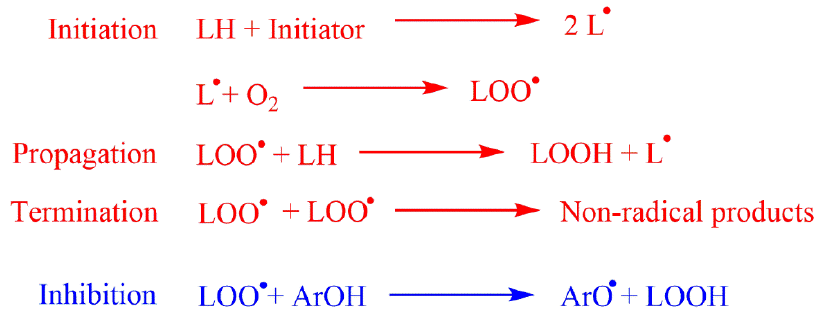
Scheme 2. Relevant reactions developed during free radical oxidation (red) of lipids (LH) and its inhibition (blue) by phenolic (ArOH) antioxidants. L  = lipid radical, LOO  = peroxyl radical, LOOH = hydroperoxide, ArO  = phenolic antioxidant radical.